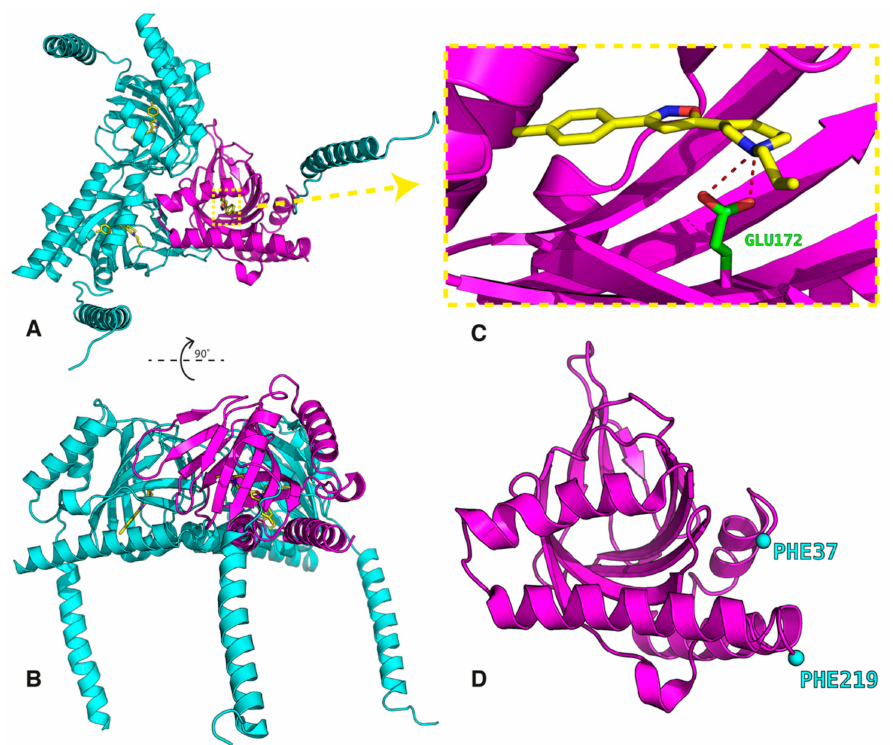
Figure 1. Structure of the human sigma 1 ( σ 1 ) receptor (the data were taken from file PDB ID: 5HK1 [1]). Complete trimer ( A and B ), the ligand PD144418 binding site ( C ), and the fragment of the receptor extracted for the docking simulations ( D